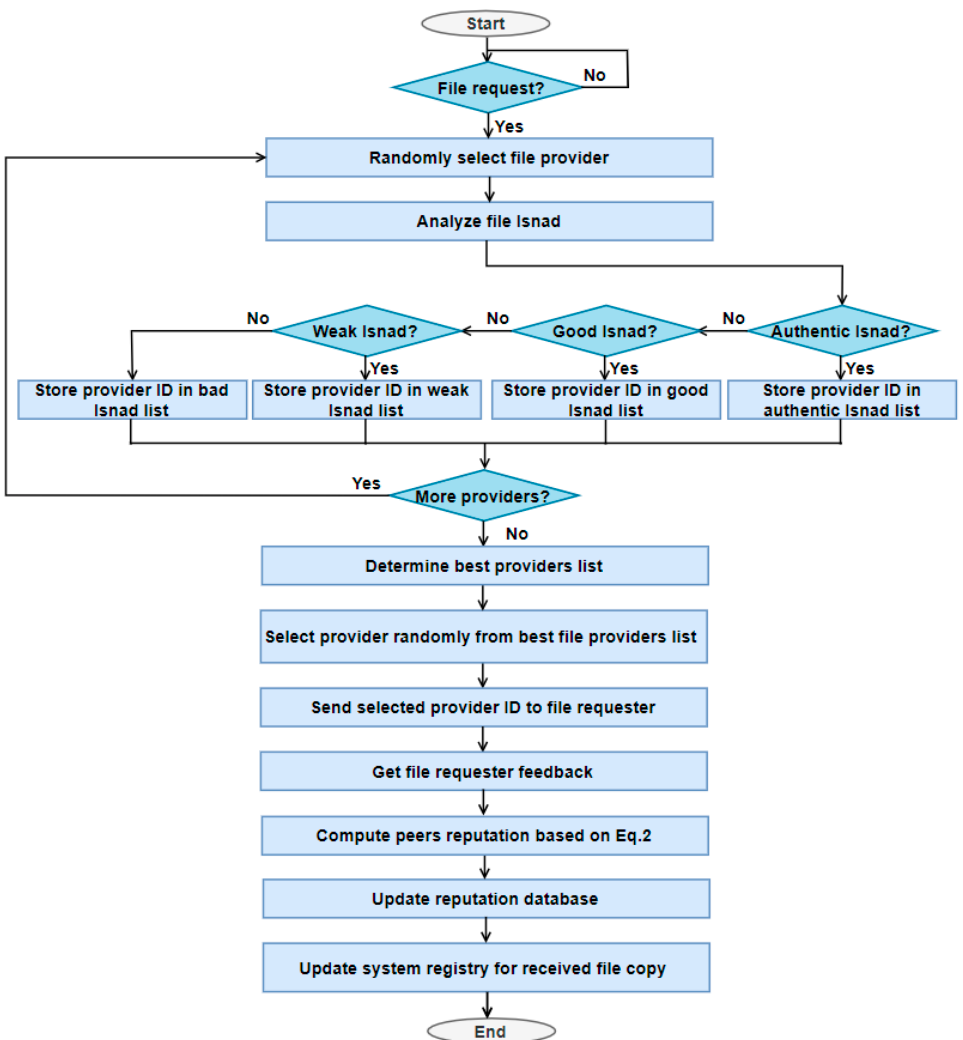
Figure 8. HadithTrust algorithm flowchart.